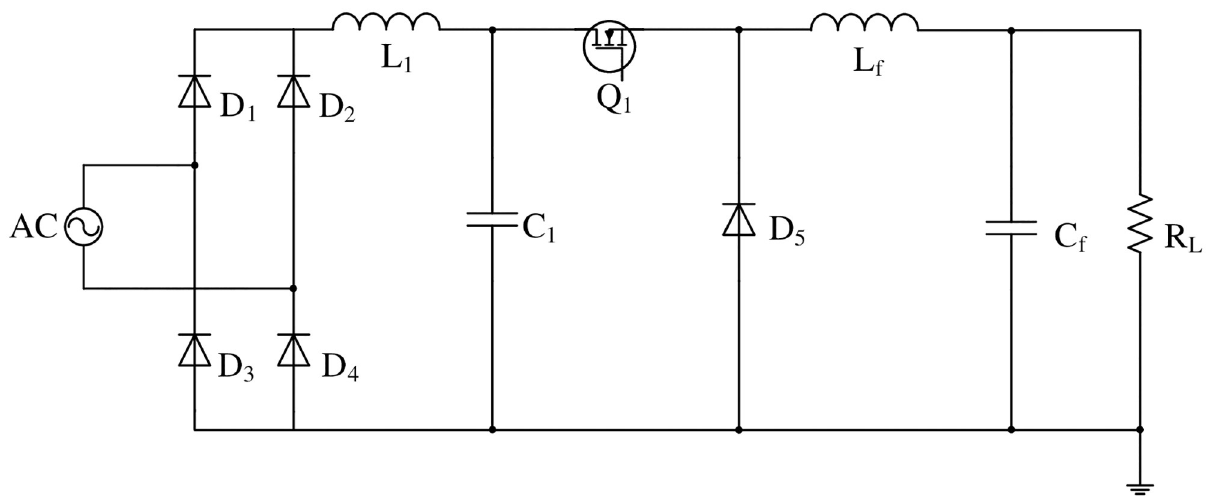
Fig 1. Buck PFC circuit operating in DCVM mode.